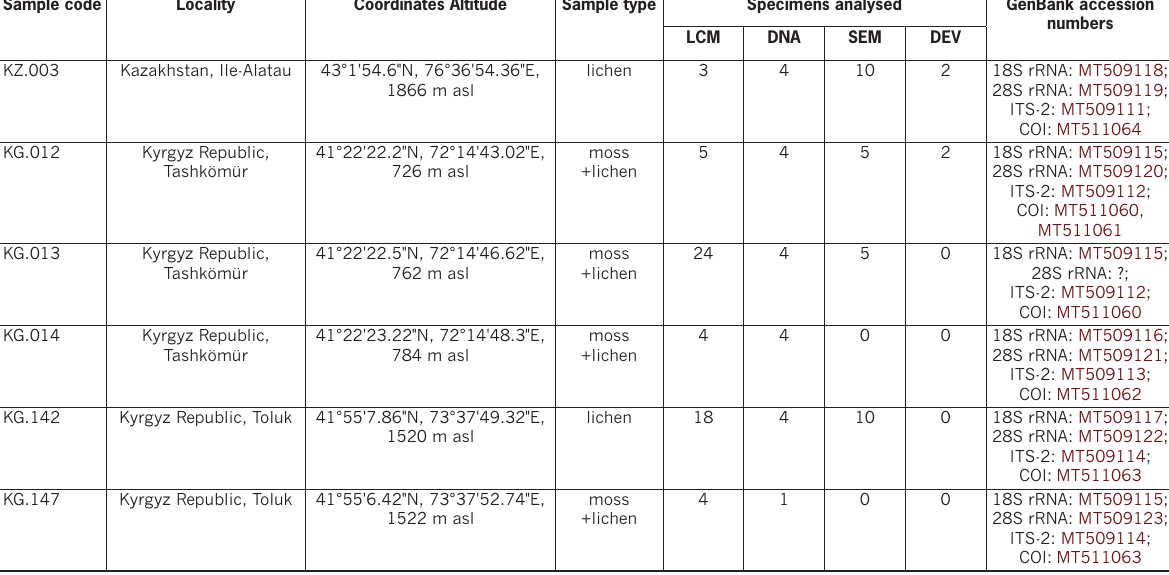
Table 1. The collection details of populations analysed in this study. Analysis types: LCM – morphometry and general morphol - ogy in PCM; DNA – DNA extraction and sequencing; SEM – imaging in SEM; DEV – developmental analysis (hatching). The “?” indicates the lacking